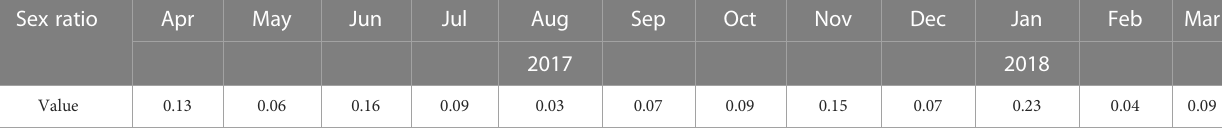
TABLE 3 The sex ratio (males/females) of O. similis at different month in Jiaozhou Bay. Sex